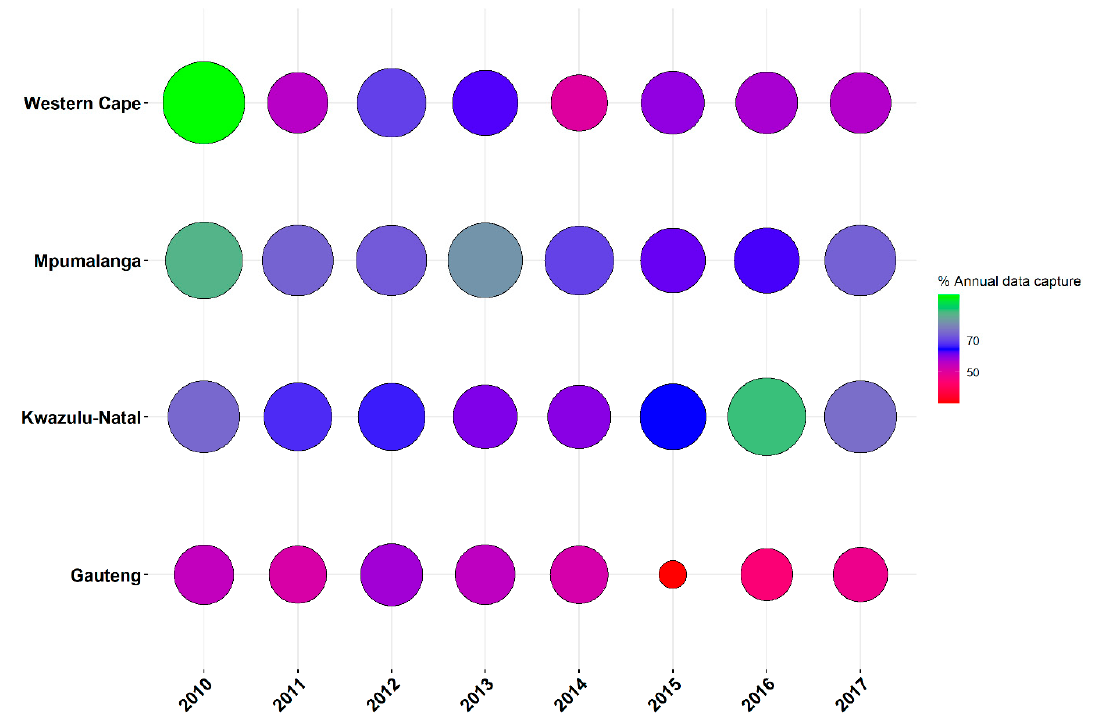
Figure 2. PM 10 data availability by year and by province—the size and colour of the circles indicate percentage of data capture per year.